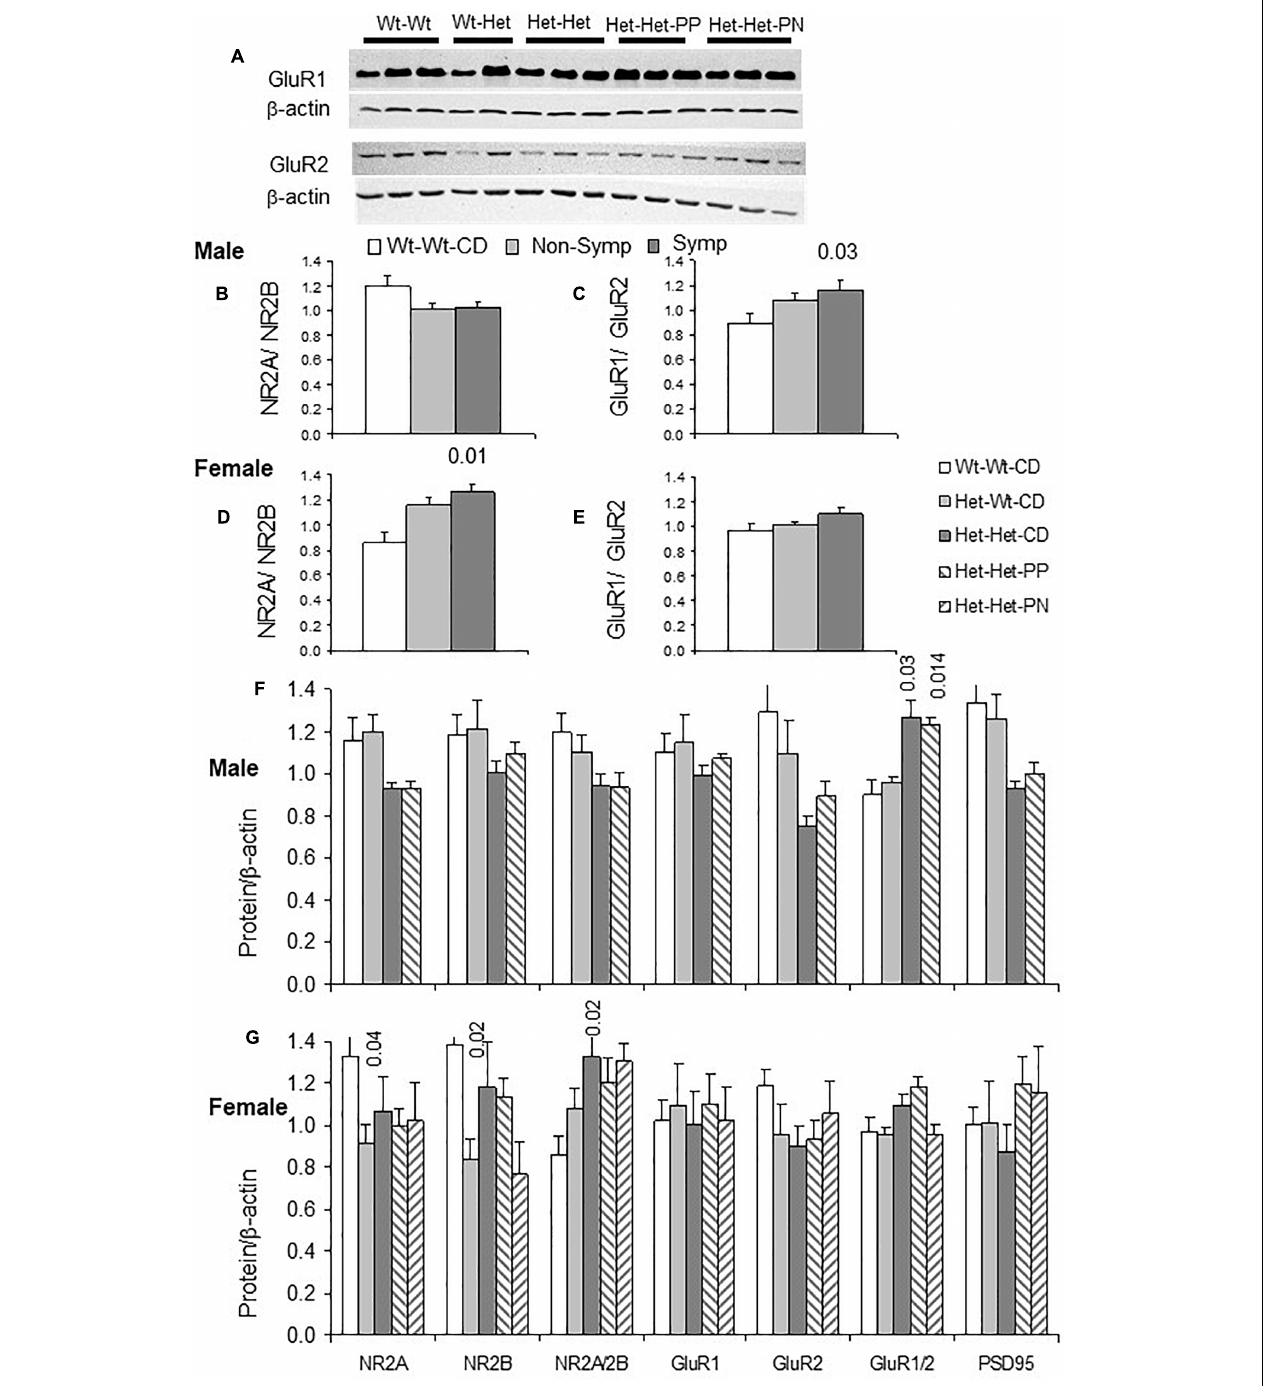
FIGURE 3 | Glutamatergic synapse: Effects of maternal and offspring genotypes, diet, sex and behavioral phenotype on the cerebral cortex. (A) Examples of GluR1 and GluR2 blots. GluR1/GluR2 and NR2A/NR2B ratios presented by behavioral categories in males (B,C) and females (D,E) . N, Male, Wt-Wt-CD, 8; Non-Symptomatic, 16, Symptomatic, 8. Female, Wt-Wt-CD, 11; Non-Symptomatic, 27; Symptomatic, 8. Protein levels of the glutamatergic synapse normalized to beta-actin levels (except where indicated otherwise) in male (F) and female (G) experimental groups. N, male, Wt-Wt-CD, 8; Wt-Het-CD, 5; Het-Het-CD, 7; Het-Het-PP, 6; female, Wt-Wt-CD, 9; Wt-Het-CD, 7; Het-Het-CD, 9; Het-Het-PP, 9, Het-Het-PN, 6. P -value in the figure refers to the difference obtained by a one-way ANOVA post hoc test compared to the Wt-Wt-CD group. Additional values are as follows for (F) : GluR1/GluR2 Het-Wt-CD vs. Het-Het-CD 0.04, and Het-Wt-CD vs. Het-Het-PP 0.004. In all other post hoc tests, significant differences were found only when compared to the Wt-Wt-CD group, as indicated in the figure. Data are presented as mean ± SEM.